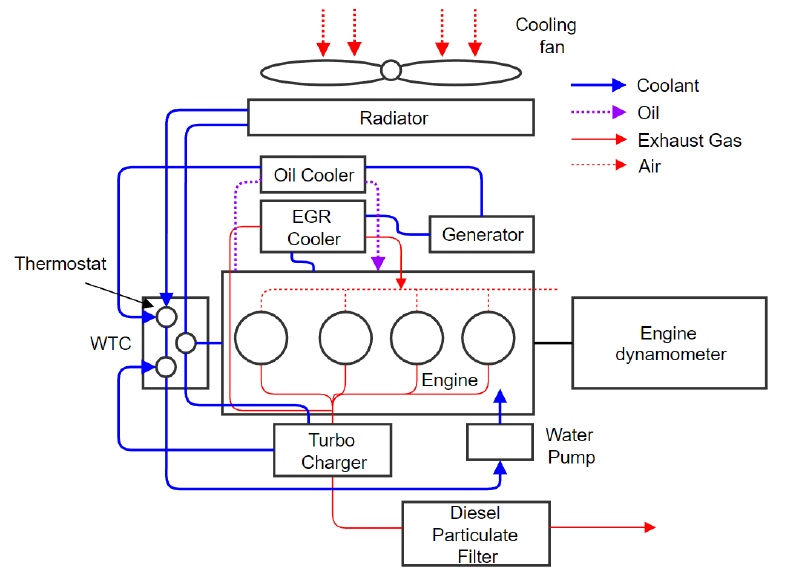
Figure 2. Schematic diagram of the diesel engine’s thermal management system.